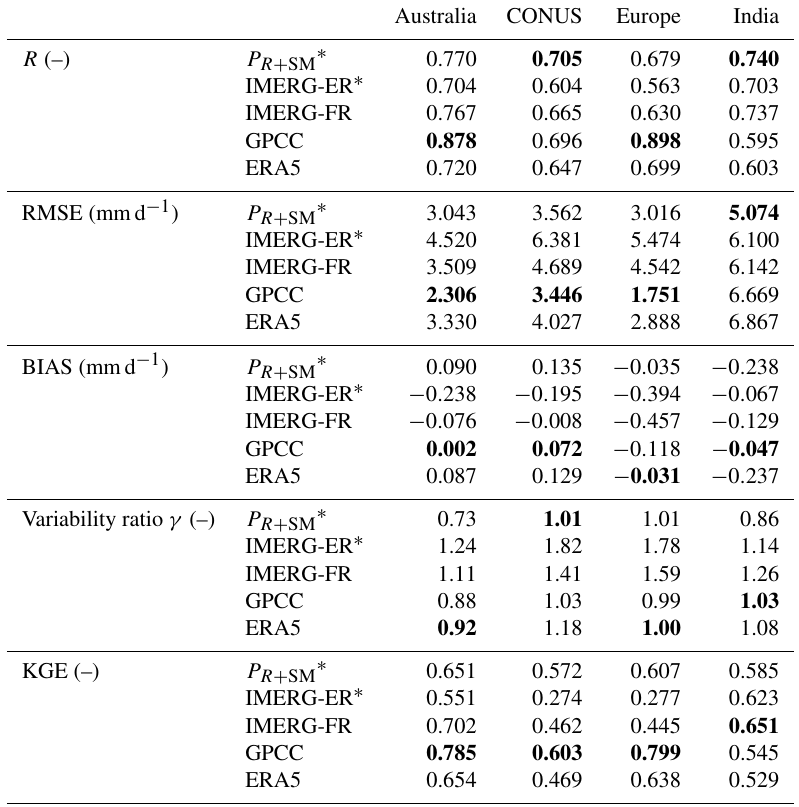
Table 3. Median correlation ( R ), root mean square error (RMSE), daily bias (BIAS), variability ratio γ (i.e. ratio between the standard deviation of the estimated rainfall and that of the benchmark) and the Kling–Gupta efficiency (KGE) index obtained with the comparison of the different rainfall products against gauge-based AWAP (Australia), Stage IV (CONUS; gauge and radar), E-OBS (Europe) and IMD (India) during the period 2015–2017. P R + SM refers to the integrated product. Asterisks refer to short-latency products, while values in bold denote the best performing product in the region according to the specific score on the